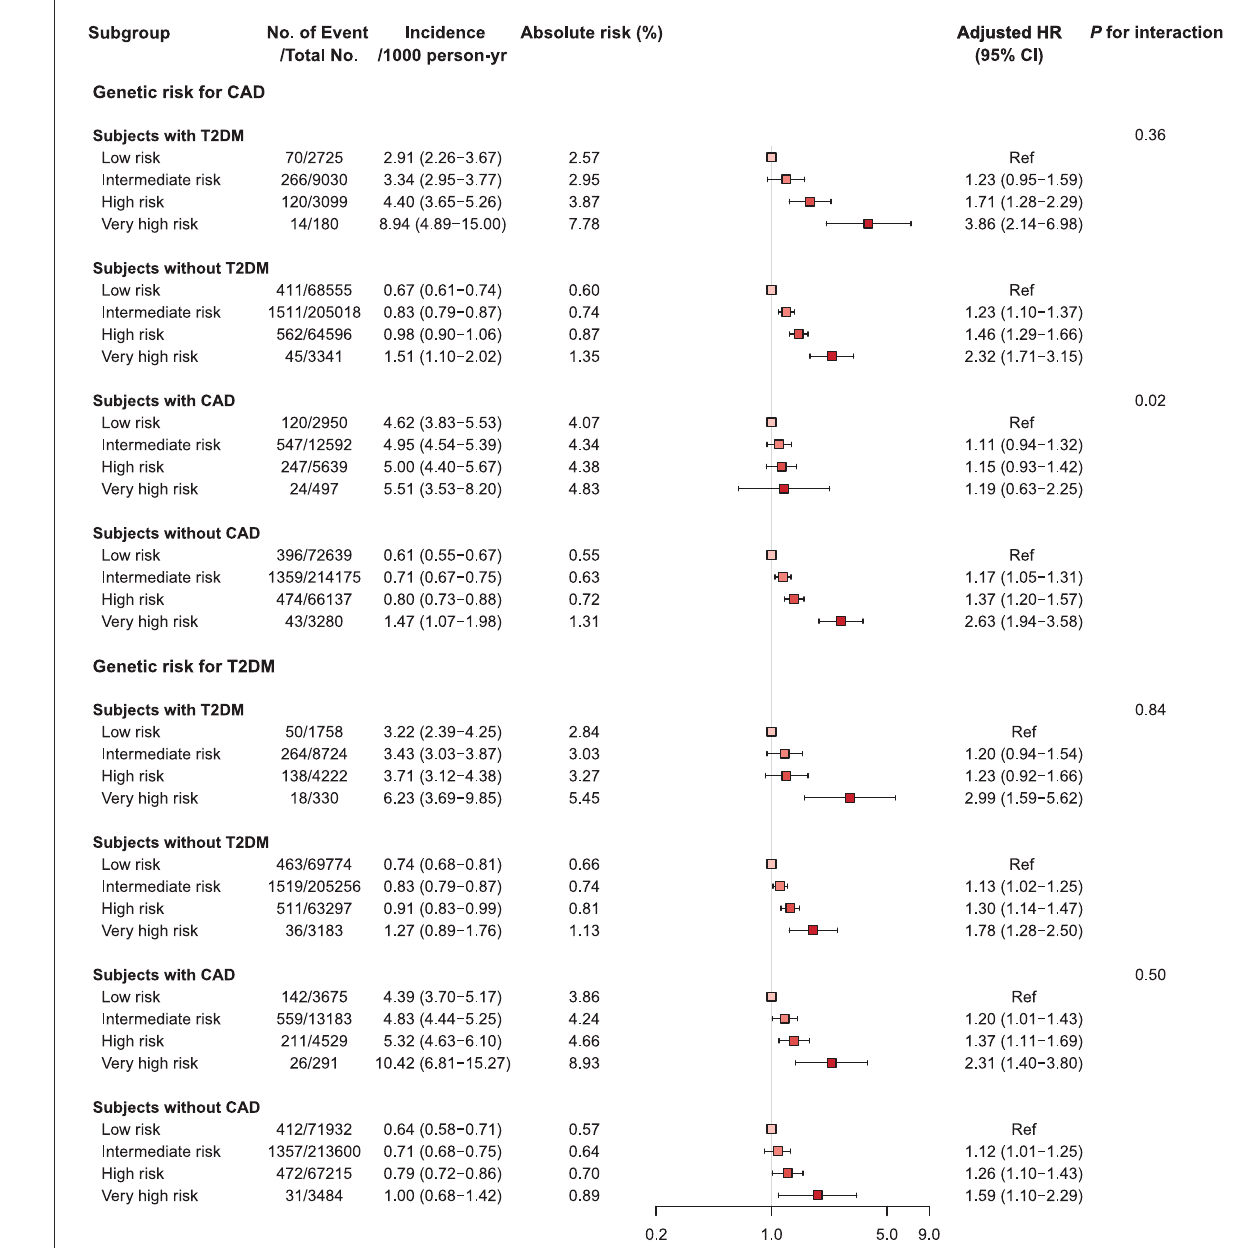
FIGURE4 Forest plot of cardiovascular mortality according to genetic risk and PRS-related disease status. PRS, polygenic risk score. Cox regression model was adjusted for age, sex, genotyping array, and first ten principal components of ancestry. p -values are for testing the interaction between each genetic risk category and disease status. CAD, coronary artery disease; CI, confidence interval; HR, hazard ratio; T2DM, type 2 diabetes